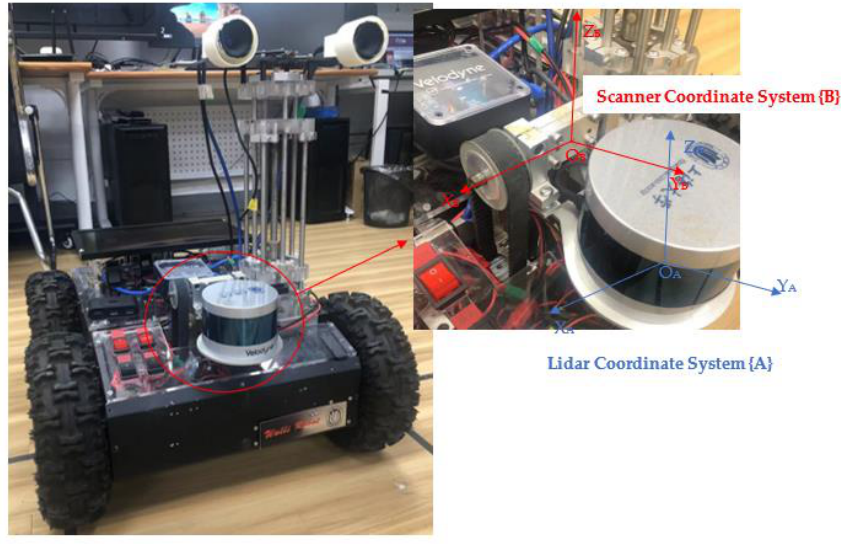
Figure 20. The dense scanning system installed on a mobile robot.